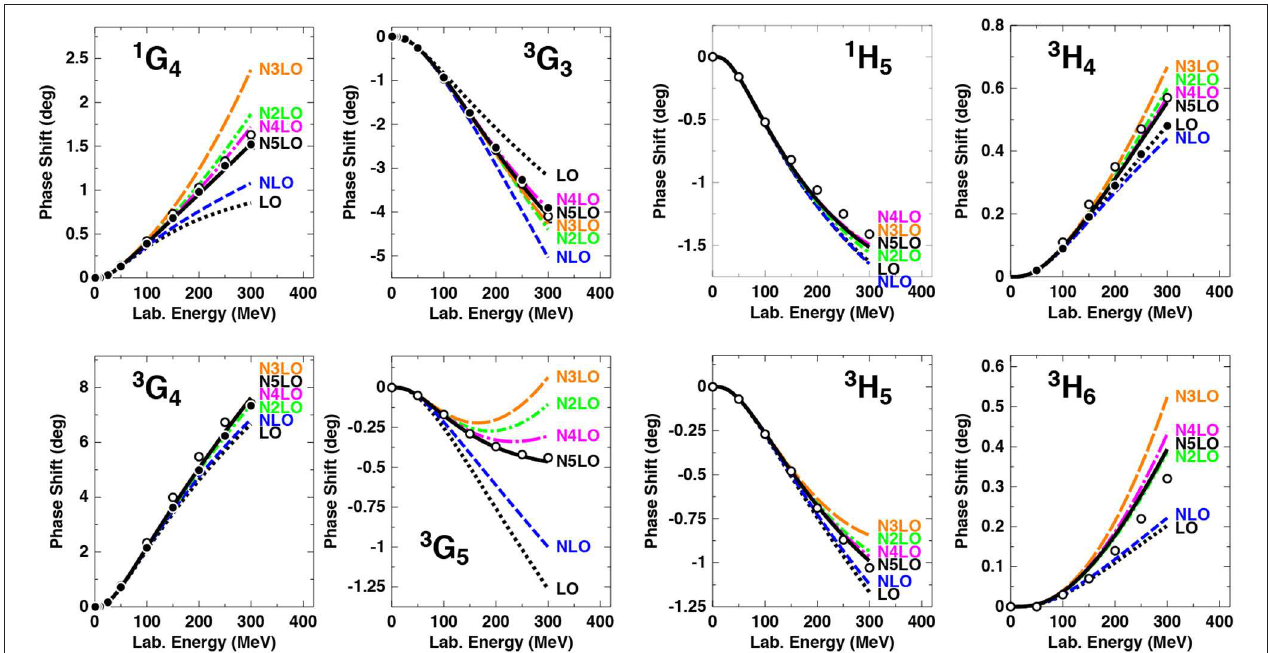
FIGURE 14 | Phase-shifts of np scattering in G and H waves at all orders from LO to N 5 LO. A SFR cut-off ˜ 3 Figure 12 . Reprinted figure with permission from Entem et al. [ 48], copyright (2015) by the American Physical Society.